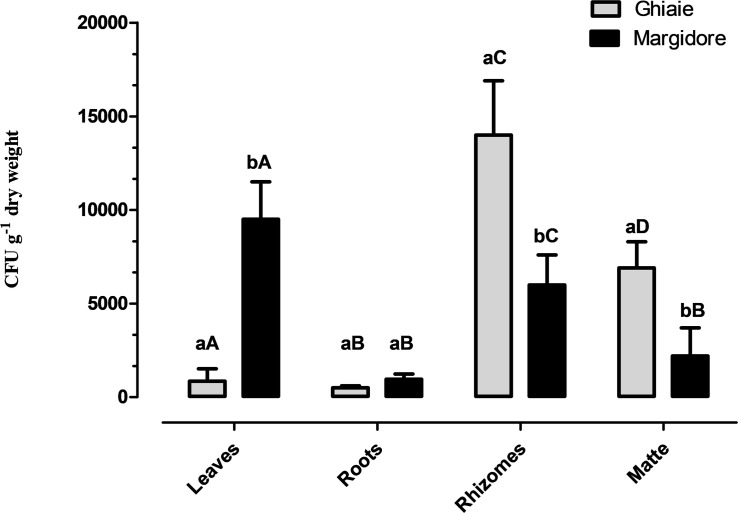
Fungal total load (CFU g– 1 dwt) detected in the four parts of P. oceanica (leaves, roots, rhizomes, and matte) in Ghiaie and Margidore. Results are expressed as mean ± SD and analyzed through two-way analysis of variance (ANOVA), Bonferroni post hoc (p < 0.05). Capital letters indicate significant differences within the same sampling site; lowercase letters indicate significant differences between sampling sites.